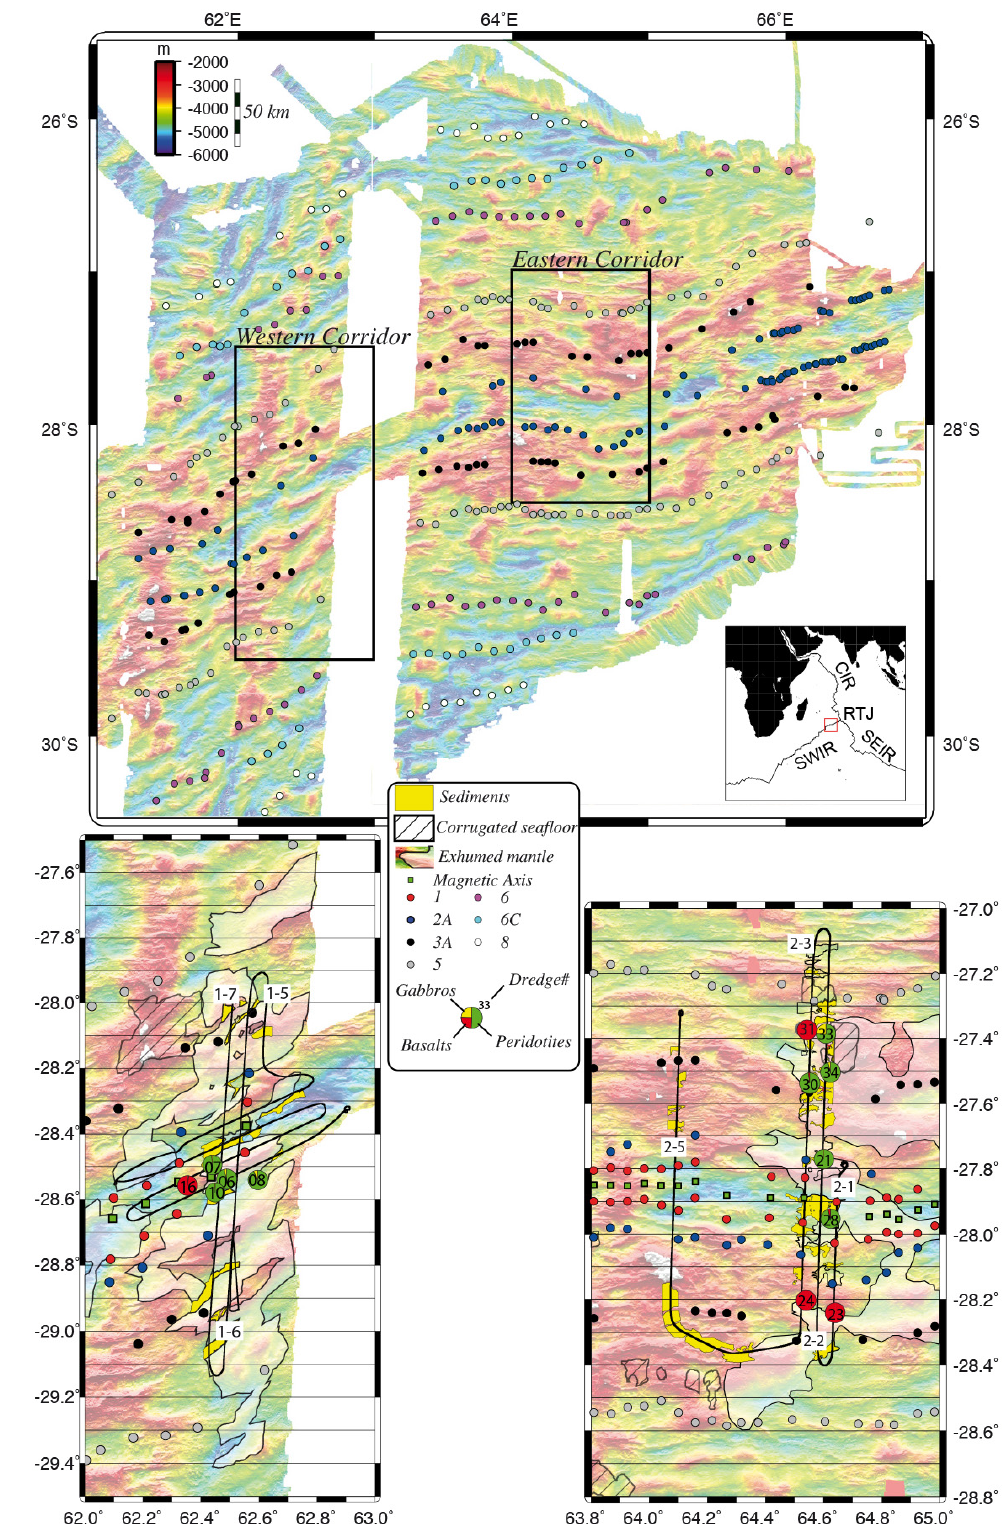
Figure 1. Bathymetric map with the location of the two survey areas (western and eastern corridor). Magnetic anomaly picks are from Sauter et al. (2008). The nature of the seafloor was deduced either from the side-scan images when available (Sauter et al., 2013) or from the multibeam bathymetric data (Cannat et al., 2006). The dredge numbers and the proportion of rocks by weight shown as pie charts are from Sauter et al. (2013). We have only shown the dredges for which we measured the magnetic properties (see Table 1 and Figs. 3 and 5). www.solid-earth.net/5/339/2014/ Solid Earth, 5, 339–354,